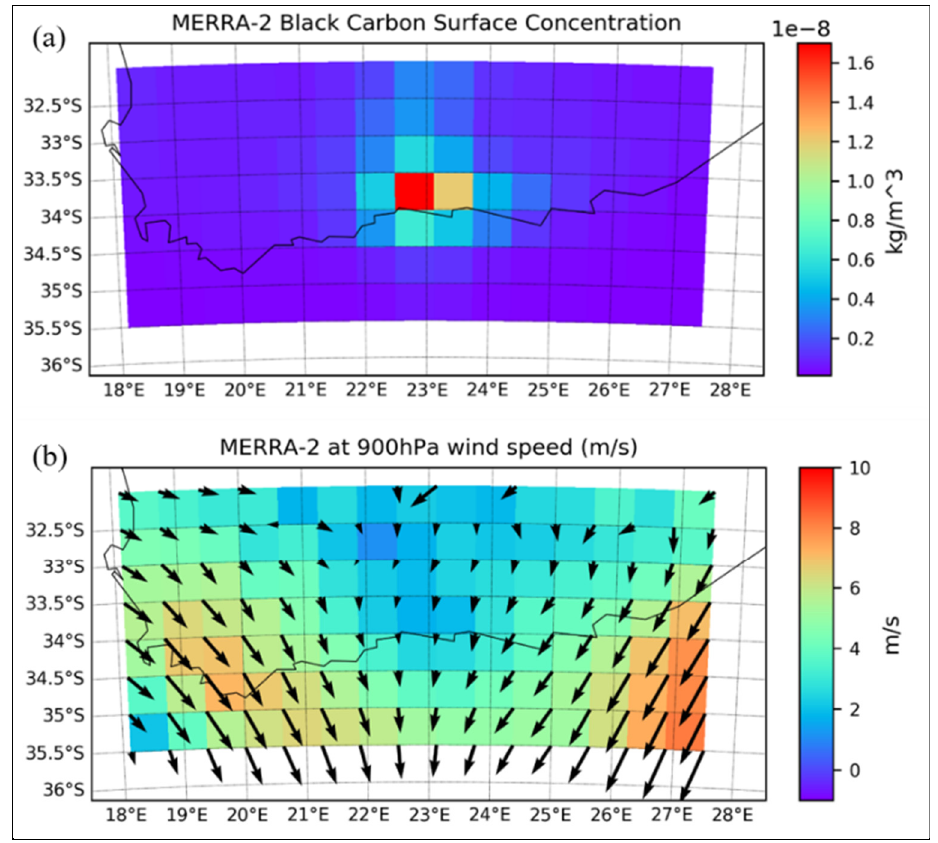
Figure 8. ( a ) Black carbon surface concentration and ( b ) Surface wind speed averaged 3-hourly over the Southern Cape from 26–29 October 2018.